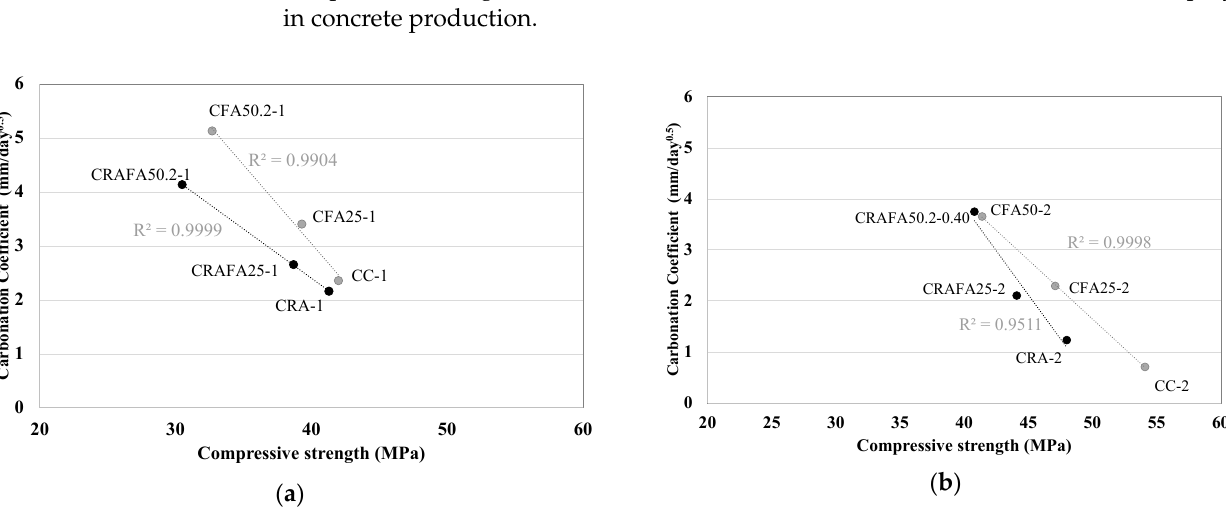
Figure 8. Compressive strength versus carbonation depth for all the concretes. ( a ) Series 1 and ( b ) Series 2. The concretes produced with RCA are represented by the black dots.